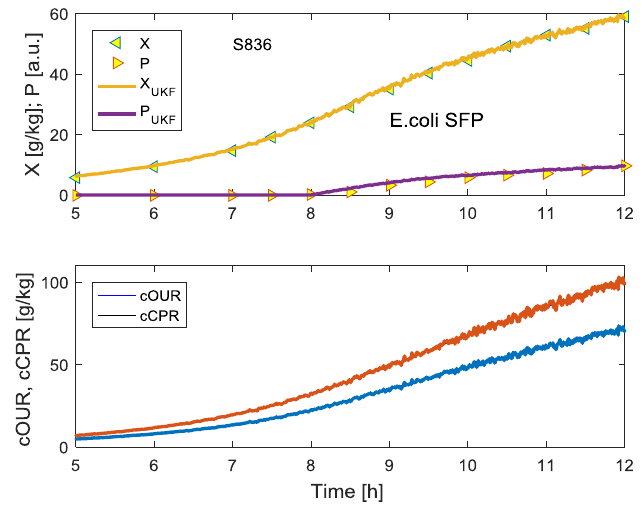
Figure 4. Results corresponding to the graphs in Figure 3 with 2.5% noise on the cOUR and cCPR measurements.